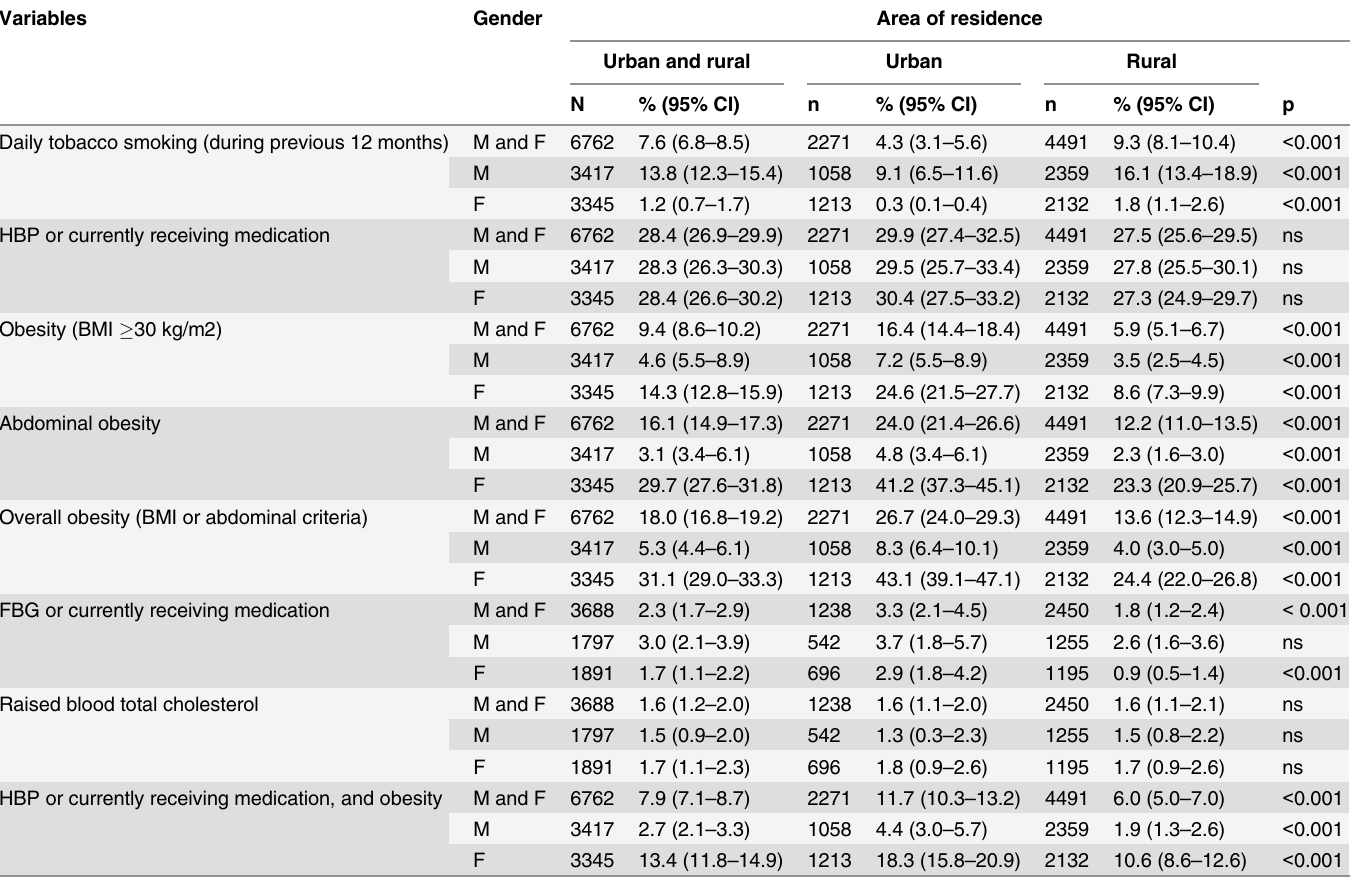
Table 4. Magnitude of cardiovascular risk factors among 25 – 64 year old population in Benin stratified by area of residence and gender (weighted prevalences from Steps Benin 2008